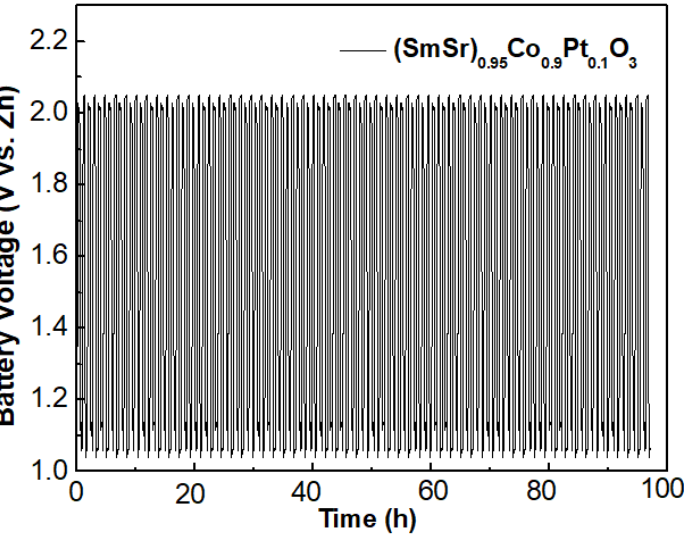
Figure 9. The galvanostatic charge–discharge profiles of rechargeable Zn–air batteries incorporated with catalyst (SmSr) 0.95 Co 0.9 Pt 0.1 O 3 mixture at 5 mA cm −2 .